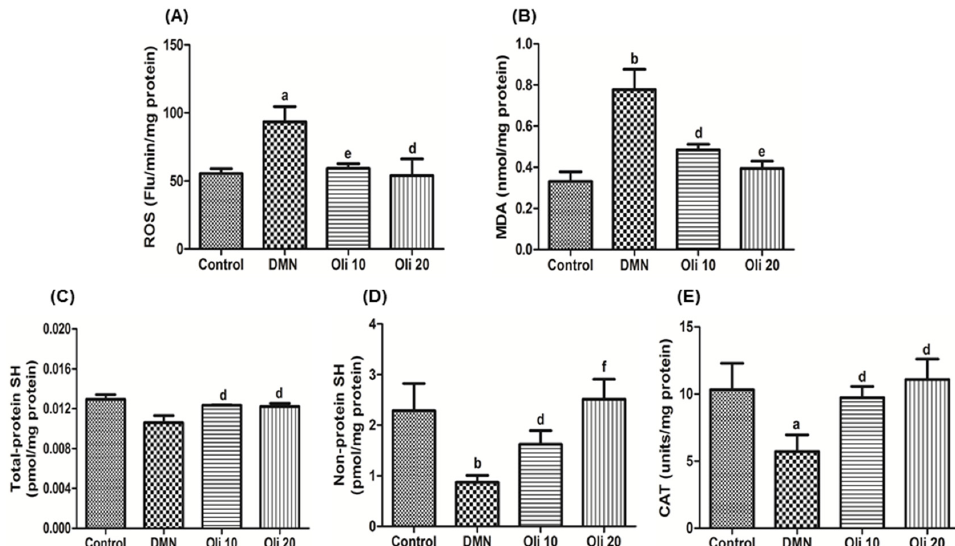
Figure 4. Effect of oligonol on reactive oxygen species (ROS, A ), malondialdehyde (MDA, B ), total SH ( C ), non-protein SH levels ( D ), and catalase activity ( E ) in rat livers intoxicated with DMN. Values are mean ± SE of n = 6 rats/group. a p < 0.05 and b p < 0.01 vs. the control group, and d p < 0.05, e p < 0.01, and f p < 0.001 vs. the DMN group.